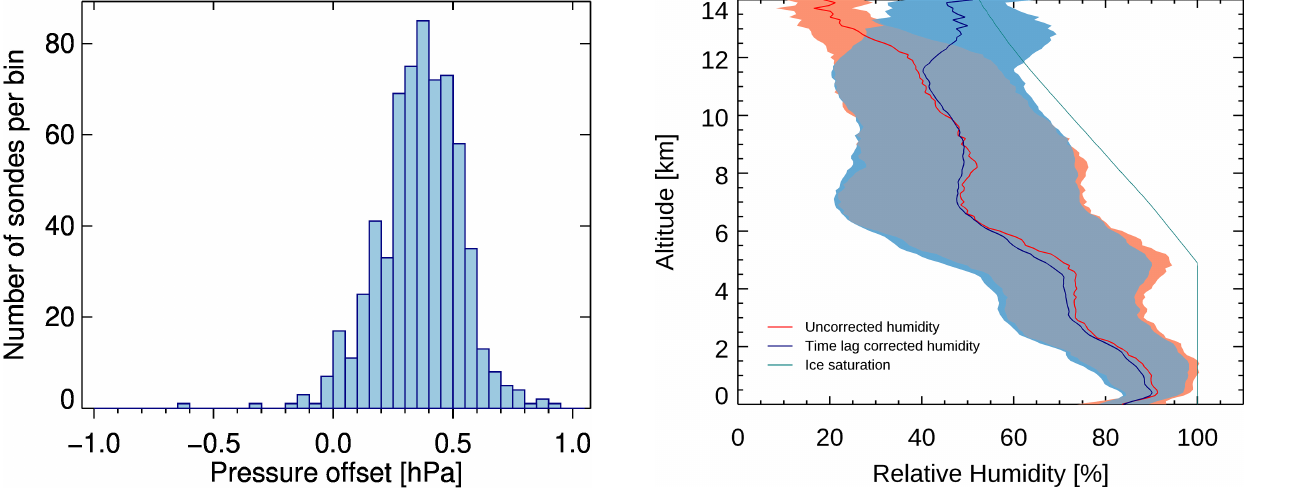
Figure 3. Pressure offset between the dropsonde and the reference sensor before launch.